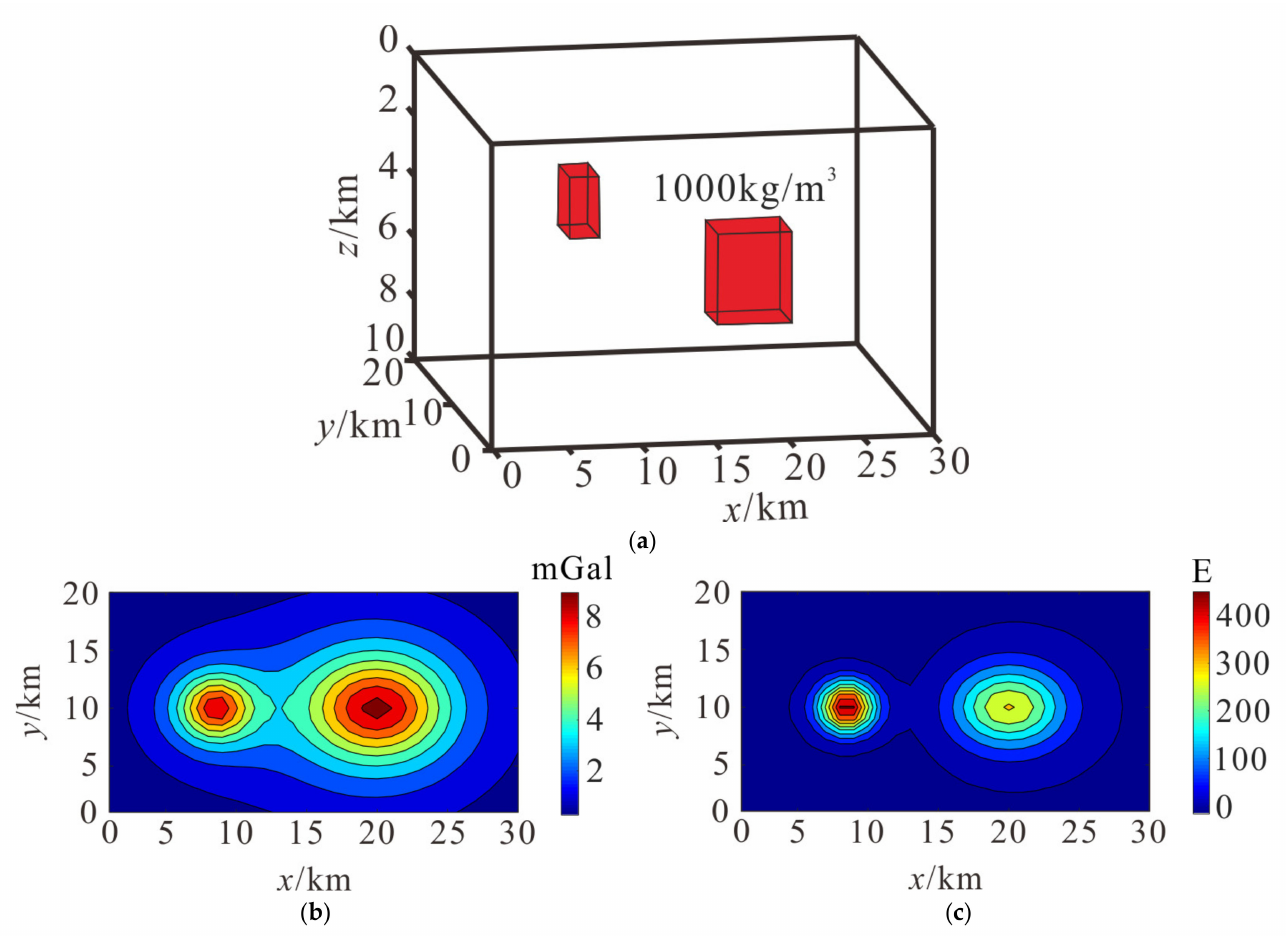
Figure 2. Information of models in different depth. ( a ) Density models with 1000 kg/m 3 . ( b ) Airborne gravity anomaly at 100 m altitude. ( c ) Vertical gradient anomaly of airborne gravity data at 100 m